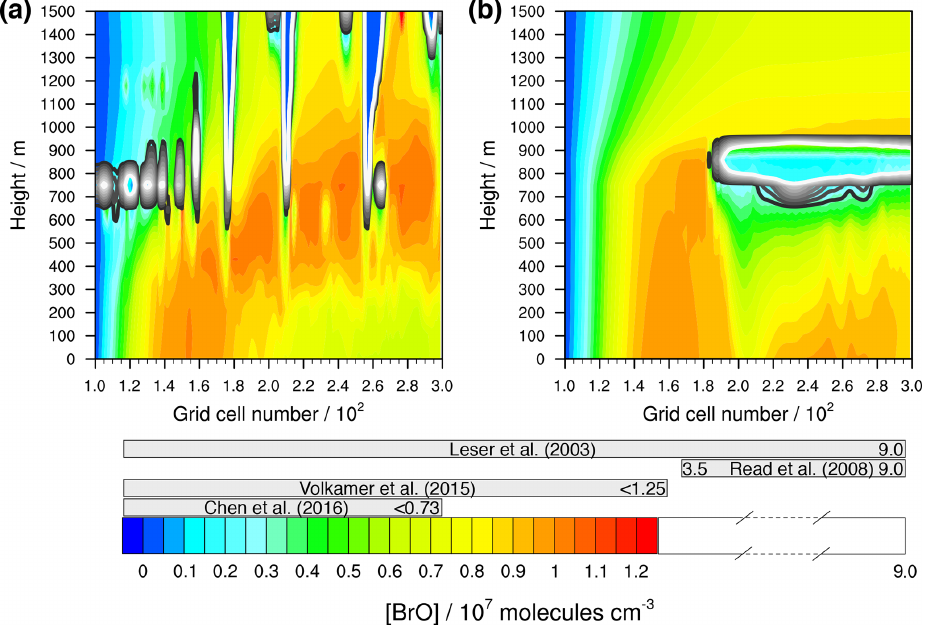
Figure 6. Simulated concentrations of bromine monoxide in the gas phase by COSMO-MUSCAT (a) in the unstable meteorological condition simulation with convective clouds and (b) in the stable meteorological condition simulation with stratiform clouds after 12h of modelling time. The x axis represents the innermost horizontal grid cells divided by 100. The grey bars represent measured values in most likely pristine marine environments (see Table S11 for further details). The black contour lines represent the simulated clouds. The black line corresponds to a LWC of 0.01gm − 3 and the white line to 0.1gm − 3 . The area framed by the white line includes LWC above 0.1gm − 3